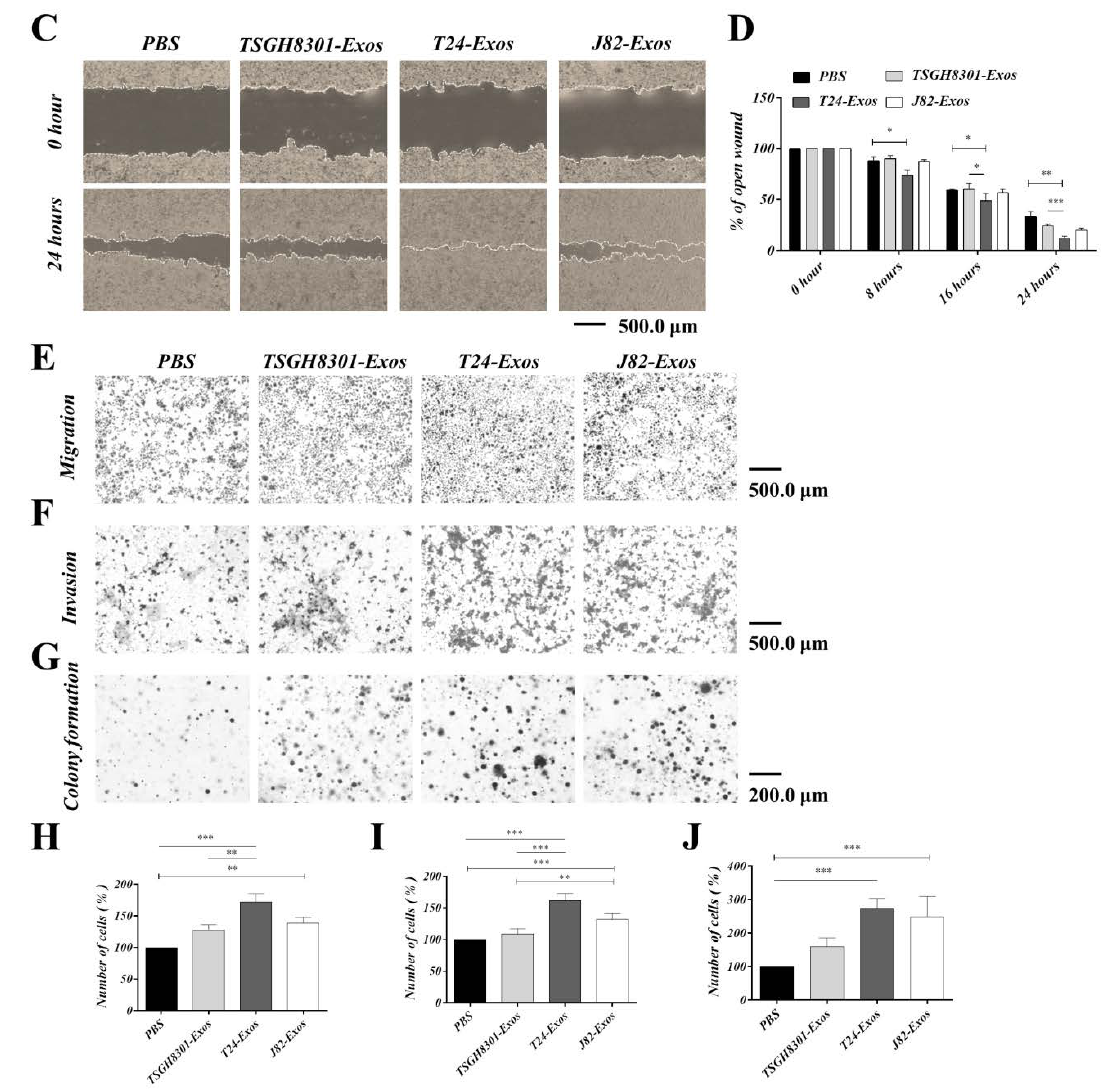
Figure 3. T24-Exos and J82-Exos intensified the aggressive behavior of TSGH-8301 cells. ( A ) Cell viability of different concentrations and ( B ) cell growth curve of different time points were compared using MTT assays in TSGH-8301 cells treated with each exosome, * p < 0.05, ** p < 0.01, *** p < 0.001. ( C , D ) The wound healing assay demonstrated that T24 and J82 cell-derived exosomes increased the migratory abilities of TSGH-8301 cells. Wound areas were photographed at 0, 8, 16, and 24 h after scratching, and representative images are shown at 0 h and 24 h after scratching. The wound closure distance was calculated with the ImageJ software. The bars represent the mean and SD of three independent experiments, * p < 0.05, ** p < 0.01, *** p < 0.001. ( E , H ) Transwell assay showed that T24 and J82 cell-derived exosomes increased the migratory abilities of TSGH-8301 cells. ( F , I ) Matrigel-coated transwell assay showed that T24 and J82 cells derived exosomes increased the invasive abilities of TSGH-8301 cells. Representative images of the ( E ) migrated and ( F ) invaded cells were photographed at 24 and 72 h after cell inoculation, respectively ( G , J ) Soft-agar colony formation assay was performed to examine the anchorage-independent survival of cells. The bar-charts showed the quantitative change in ( H ) migration, ( I ) invasion, and ( J ) cell clones, respectively. All experiments were performed at least in triplicate, * p < 0.05, ** p < 0.01, *** p <